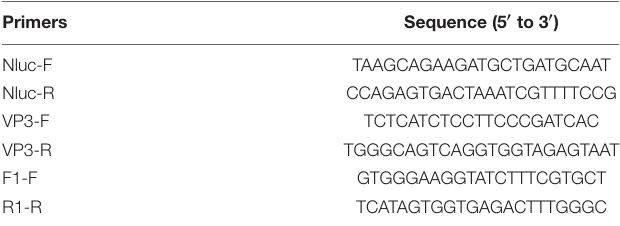
TABLE 1 | The primers used in the